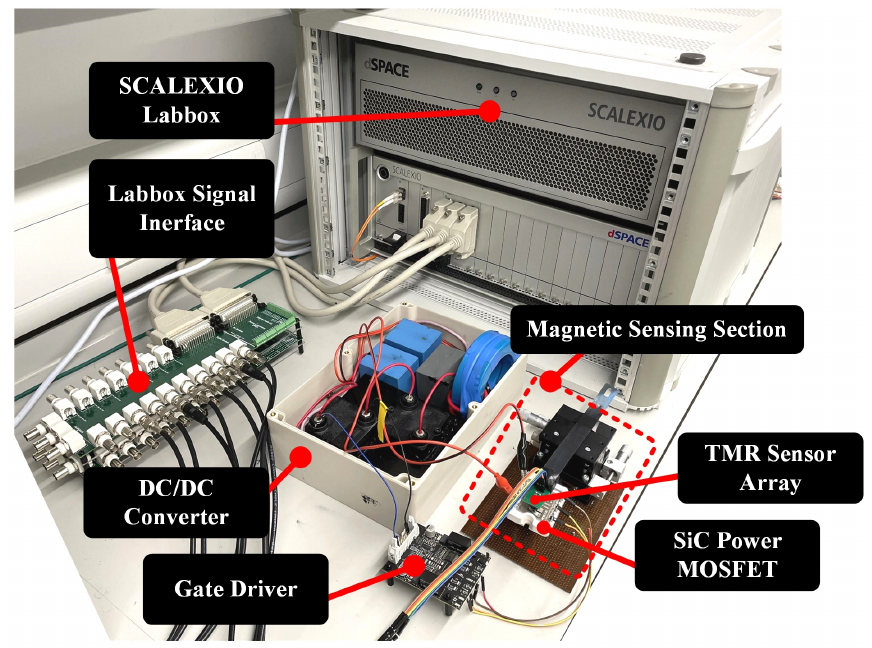
Figure 16. Experimental set-up of the proposed CM